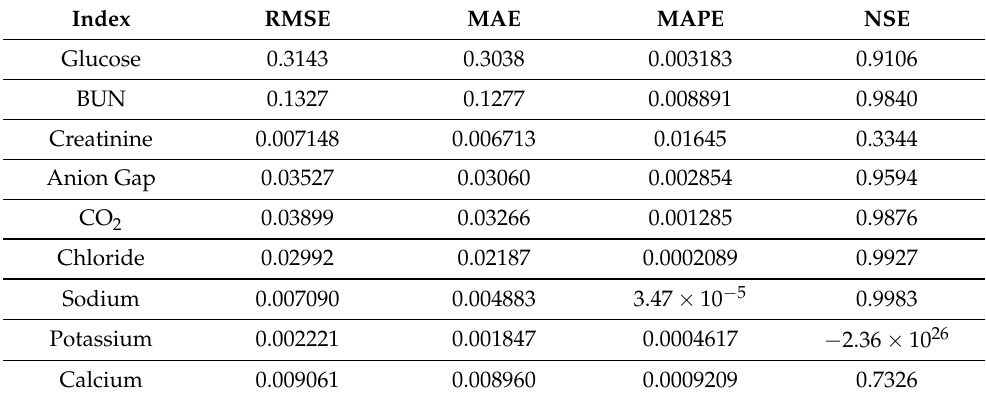
Table A7. Errors in other metrics of the one-step prediction of patient